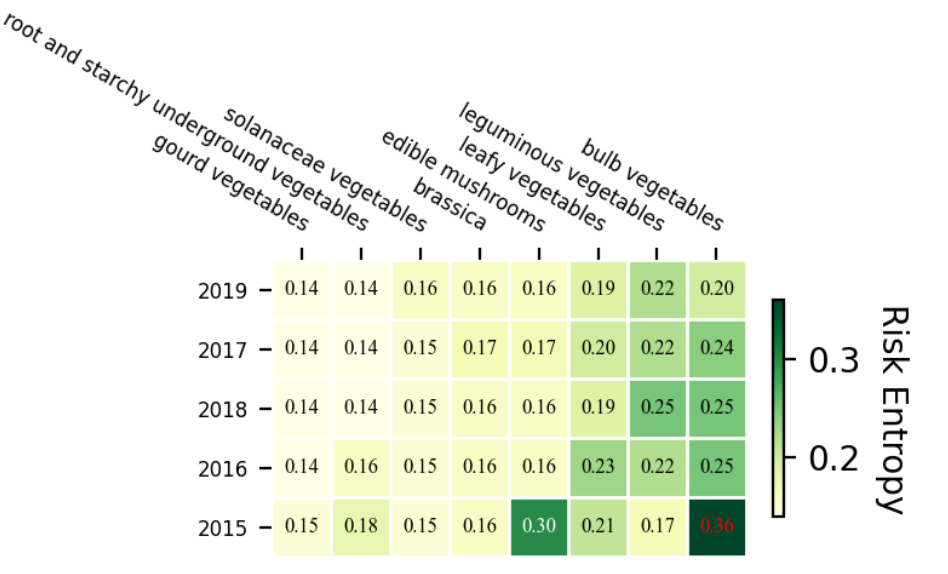
Figure 8. Heat map of the risk entropy of ‘Year + Category’, row labels are years, from 2015 to 2019 and column labels are 8 agricultural categories. Darker colours indicate higher values of the risk entropy.